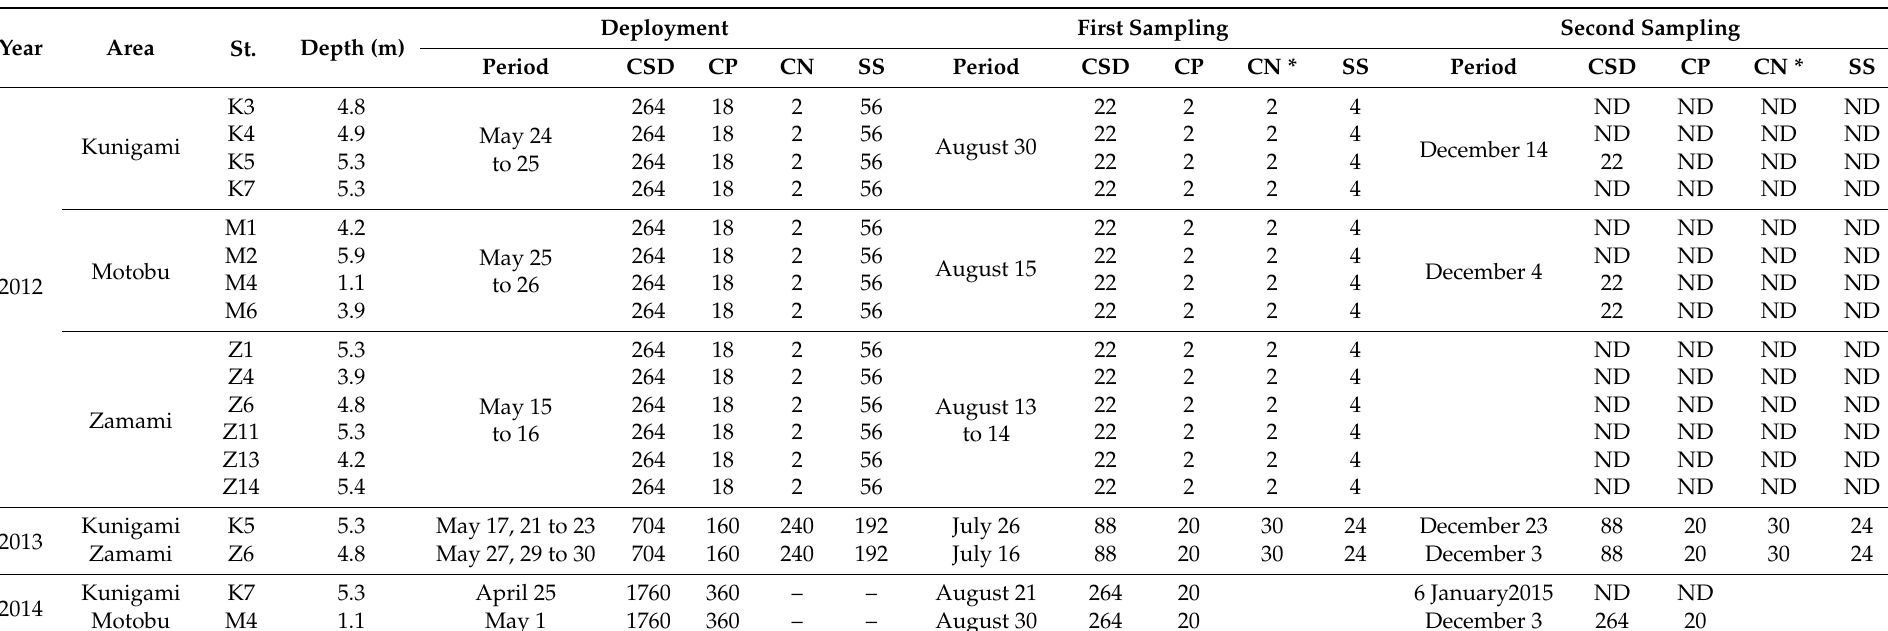
Table 2. Numbers of the substrata deployed and sampled at the study sites from 2012 to 2014. Deployment was carried out every year before the full moon in June. CSD was installed in 3 cases in 2012, 8 cases in 2013, and 20 cases in 2014. CP was installed in 1 case in 2012, 8 cases in 2013, and 18 cases in 2014. CN was installed in 1 case in 2012 and 8 cases in 2013. SS was installed in 1 case in 2012 and 8 cases in 2013. The substrata were sampled twice, about 2 months and 6 months after spawning. Sampling was performed on the sea bottom with a bundle (11 pieces) for CSD, plate for CP, face for SS, and pair (2 shells) for SS from each